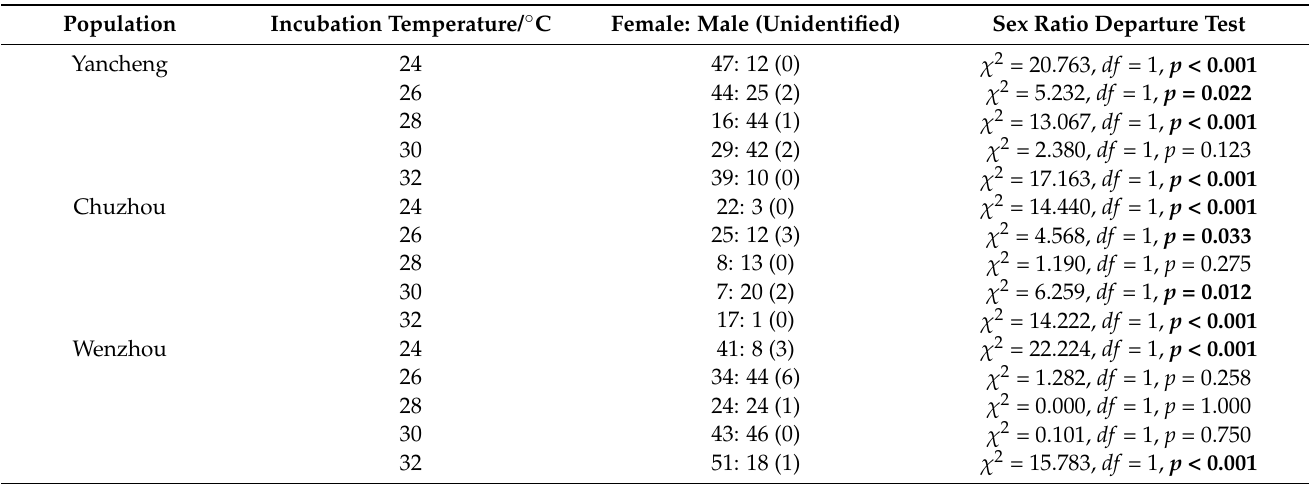
Table 2. Sex ratio of Gekko japonicus from different populations under each incubation temperature (Yancheng, northern population; Chuzhou, central population; Wenzhou, southern population). df indicates degree of freedom. p values in bold indicate significant differences.